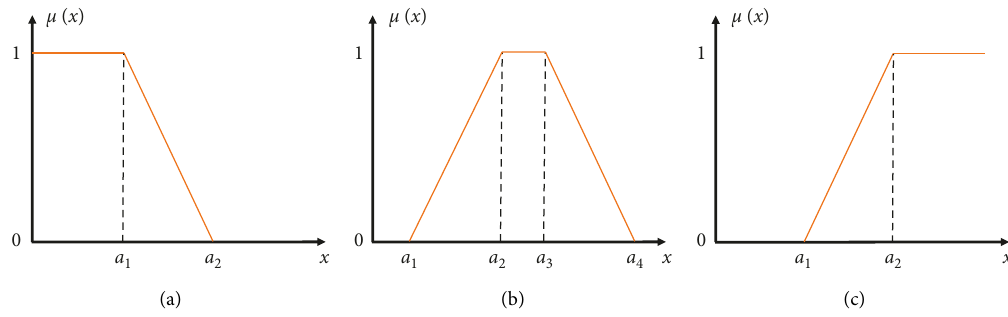
Figure 1: Three types of trapezoidal membership function images: (a) small, (b) intermediate, and (c) large